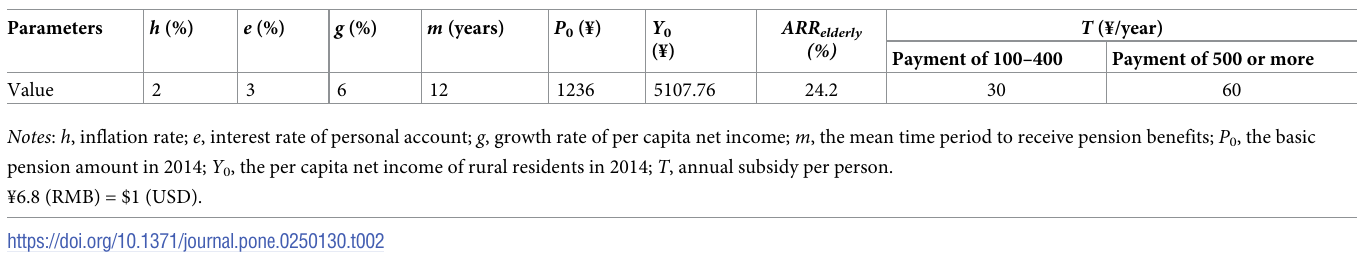
Table 2. Parameters used in the ARR actuarial